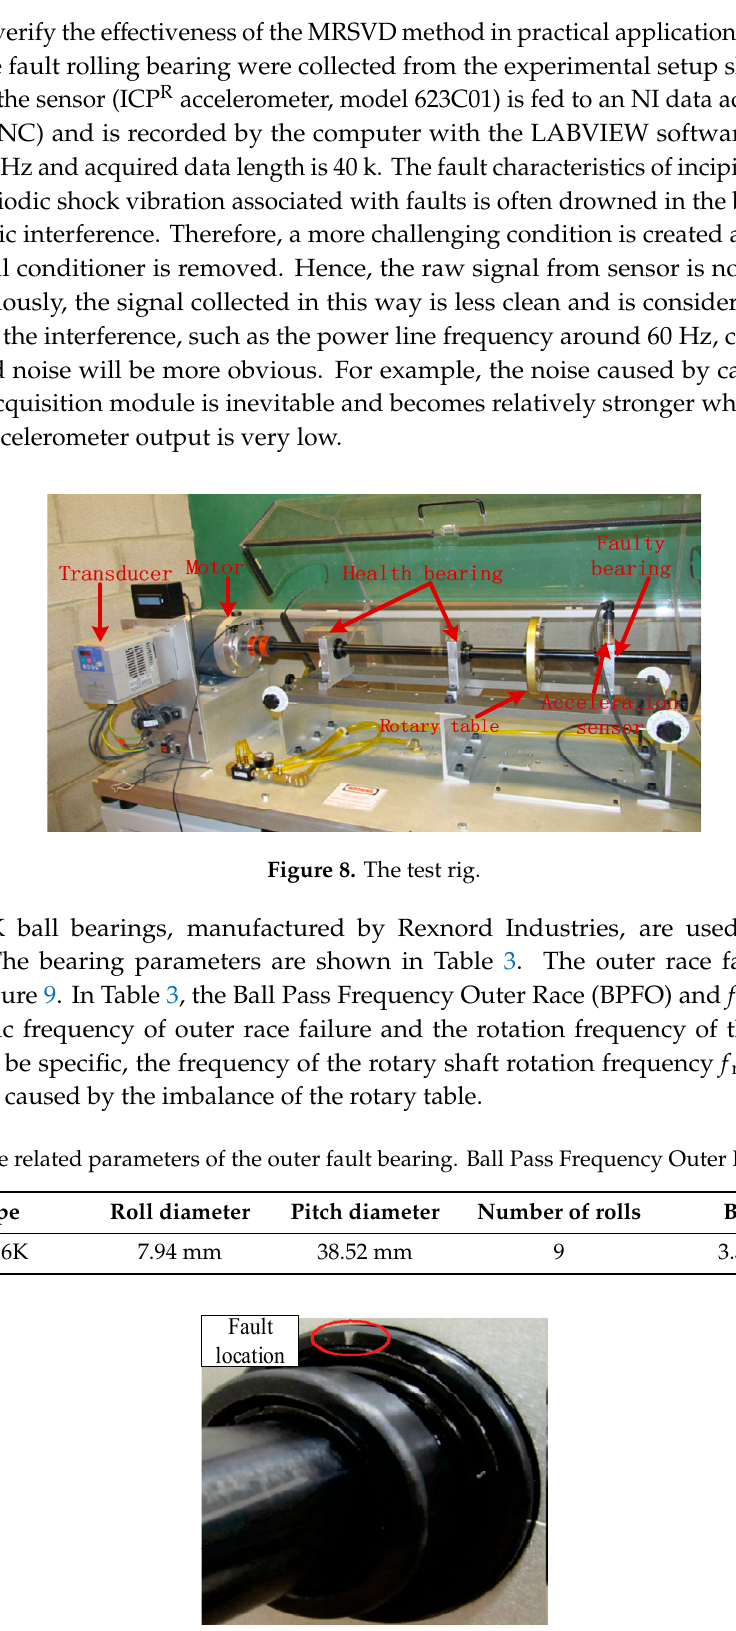
Figure 9. The fault bearing used in the experiment.